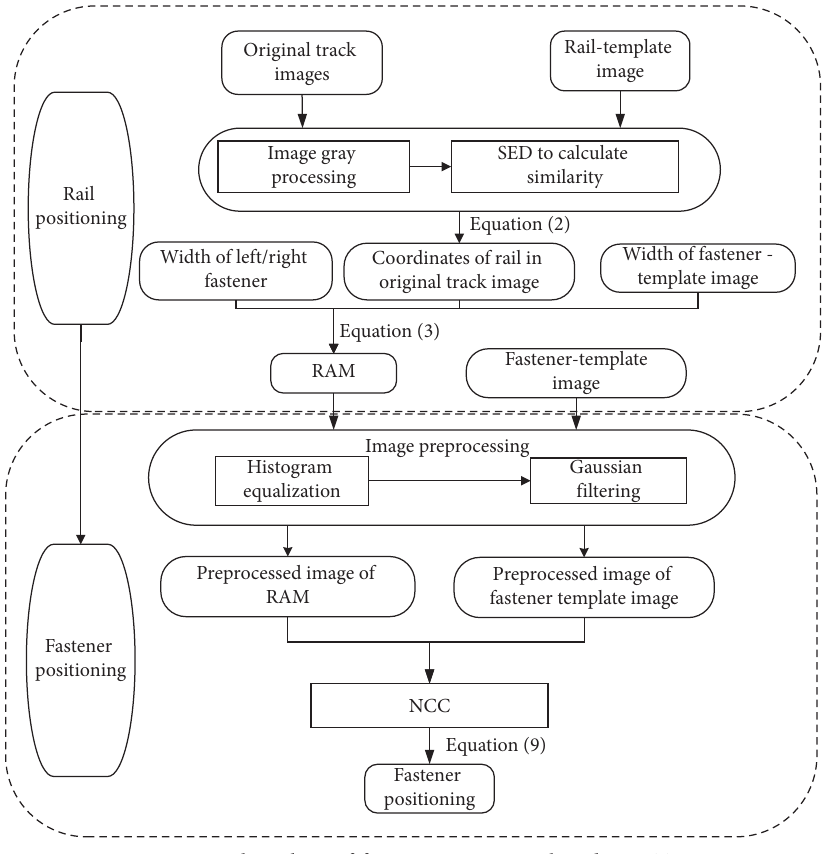
Figure 2: Flow chart of fastener positioning based on